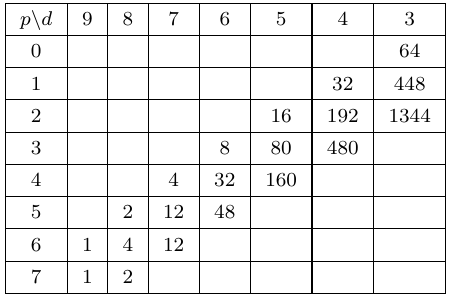
Table 26 . Number of E-branes in the p -brane multiplet in d -dimensions [11].